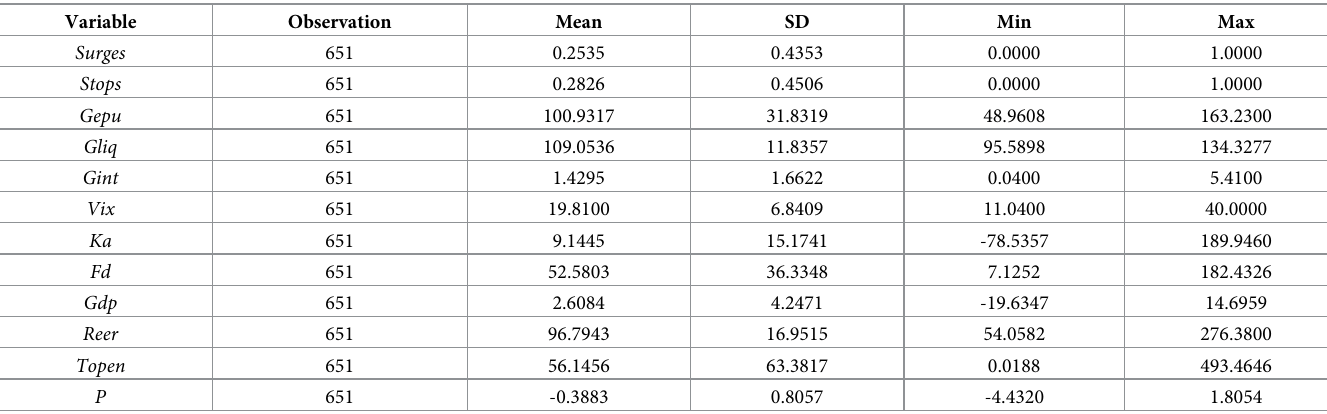
Table 2. Descriptive statistics of variables.